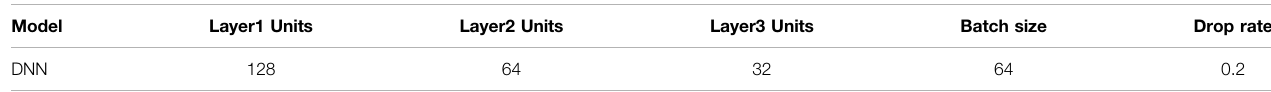
TABLE 2 | Hyperparameters for DNN model.